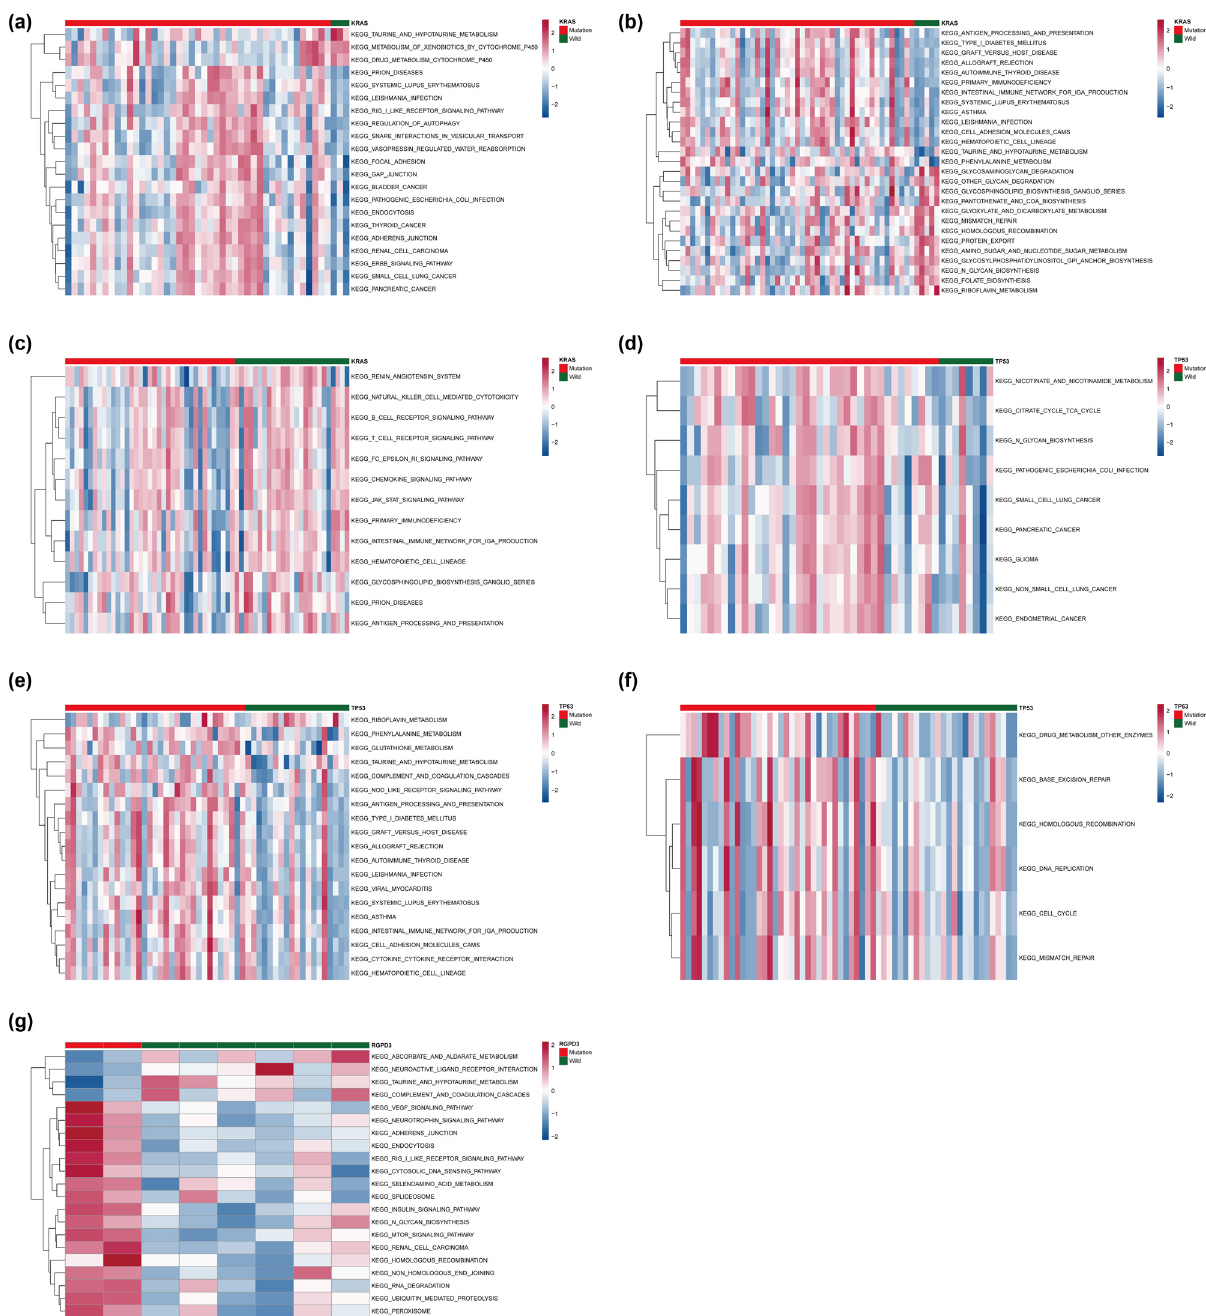
Figure 7: Signi fi cant di ff erences in KEGG pathways between samples with genetic mutations and nonmutated samples. Signi fi cant di ff er - ences in KEGG pathways between KRAS - mutated and - nonmutated samples in Clusters 1 ( a ) , 2 ( b ) , and 3 ( c ) . Signi fi cant di ff erences in KEGG pathways between TP53 - mutated and - nonmutated samples in Clusters 1 ( d ) , 2 ( e ) , and 3 ( f ) . Signi fi cant di ff erences in KEGG pathways between RGPD3 mutated and nonmutated samples in Clusters 3 ( g )